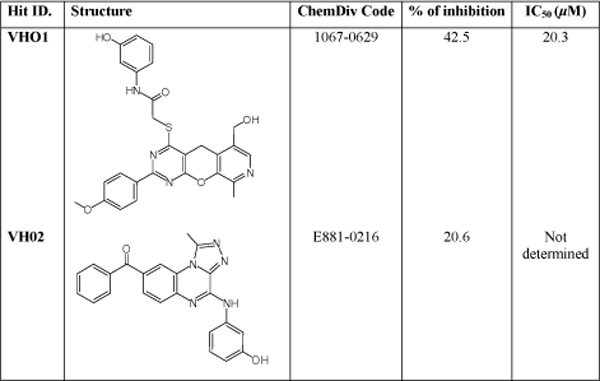
The compounds having an inhibition rate > 20% at 10μM and their IC50 values.